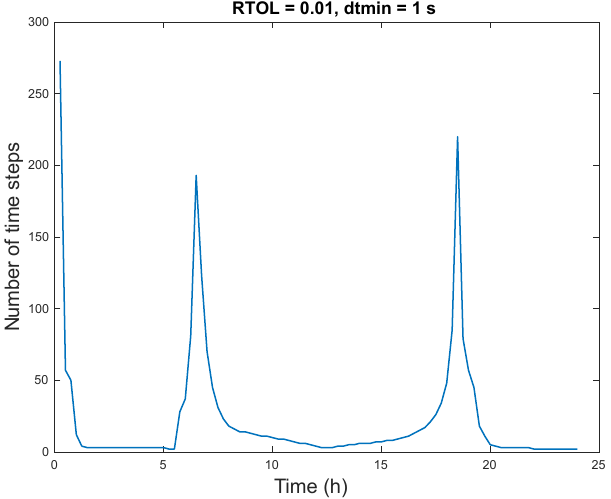
Figure 3. STRATO case. Number of time steps of the ASIS solver for each interval of 15min in experiment AS2.